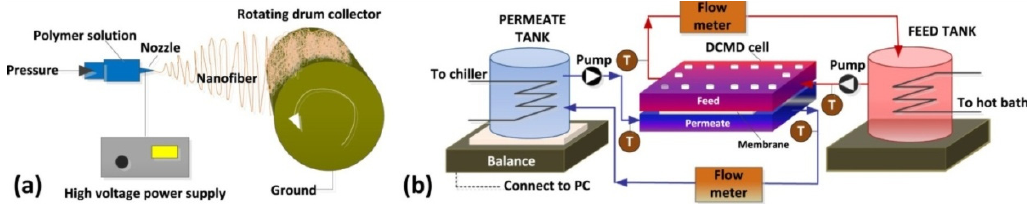
Figure 13. Schematic illustrations of the ( a ) electrospinning set-up and ( b ) direct contact membrane distillation system, diagram taken from [112].